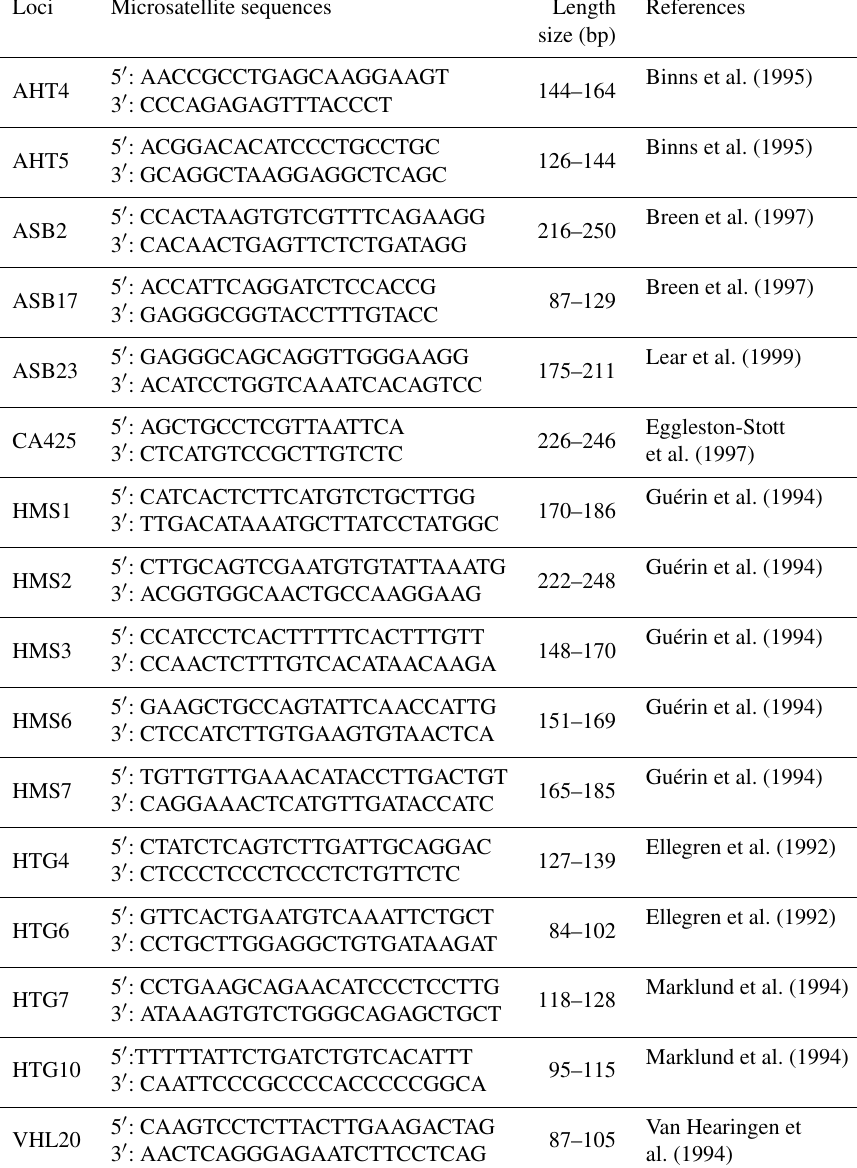
Table 1. Microsatellite sequences and length